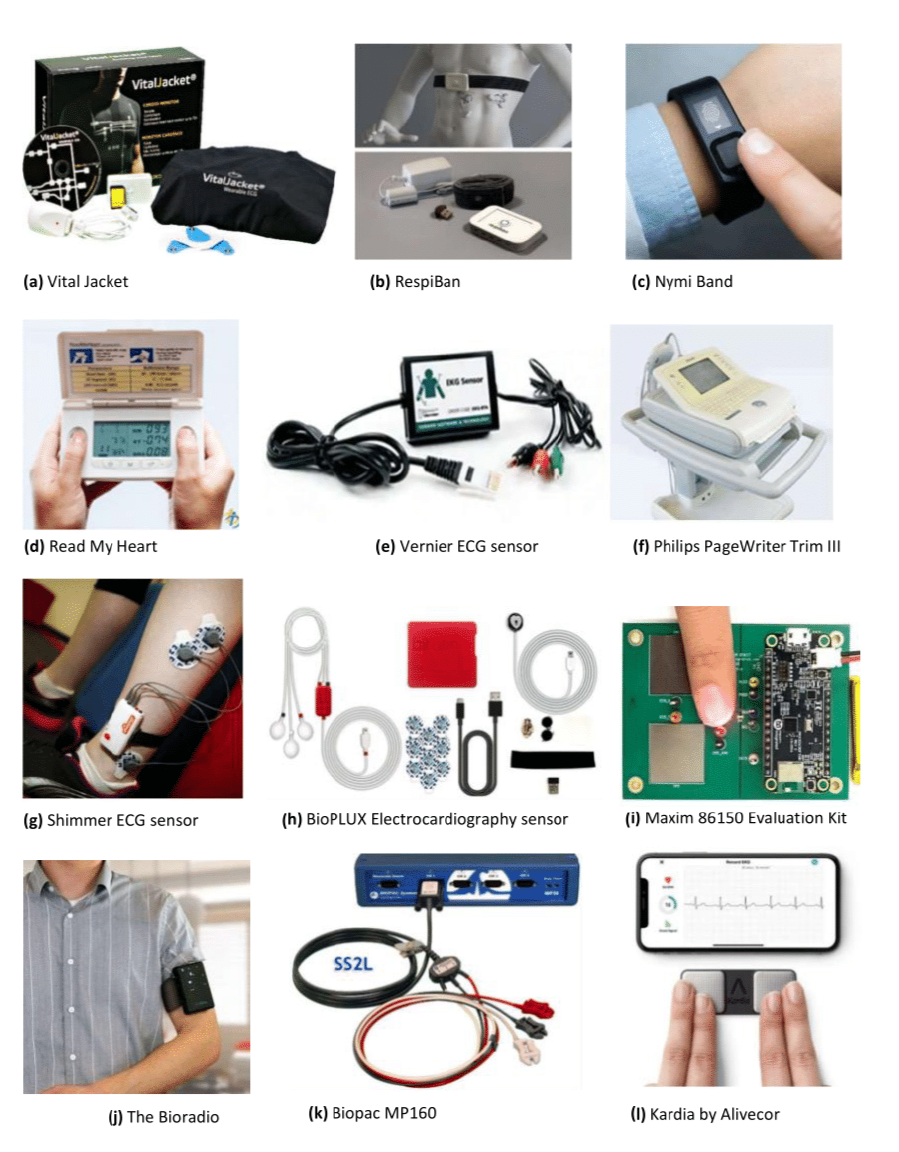
Figure 5. Commercially available